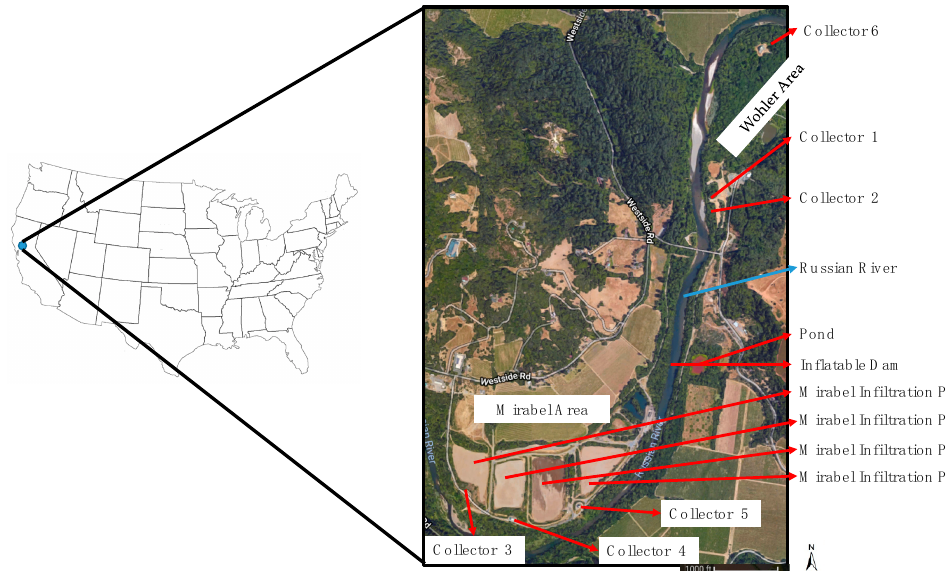
Figure 1. Project area map. Wohler (Collectors 1, 2, and 6) and Mirabel Areas (Collectors 3, 4, 5), Sonoma County Water Agency, Sonoma County, California. Modified from [3].